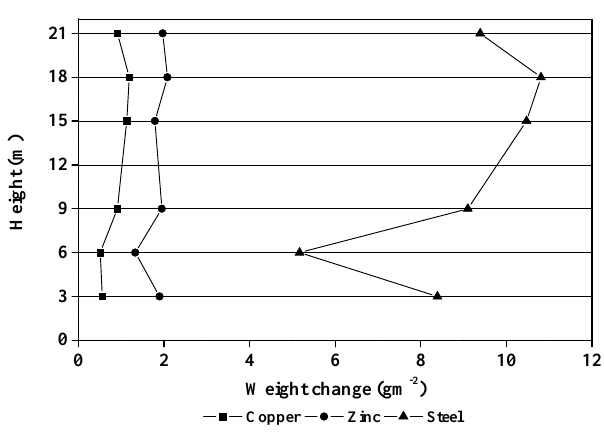
Fig. 3. Weight change of the specimens exposed for one year at specific levels